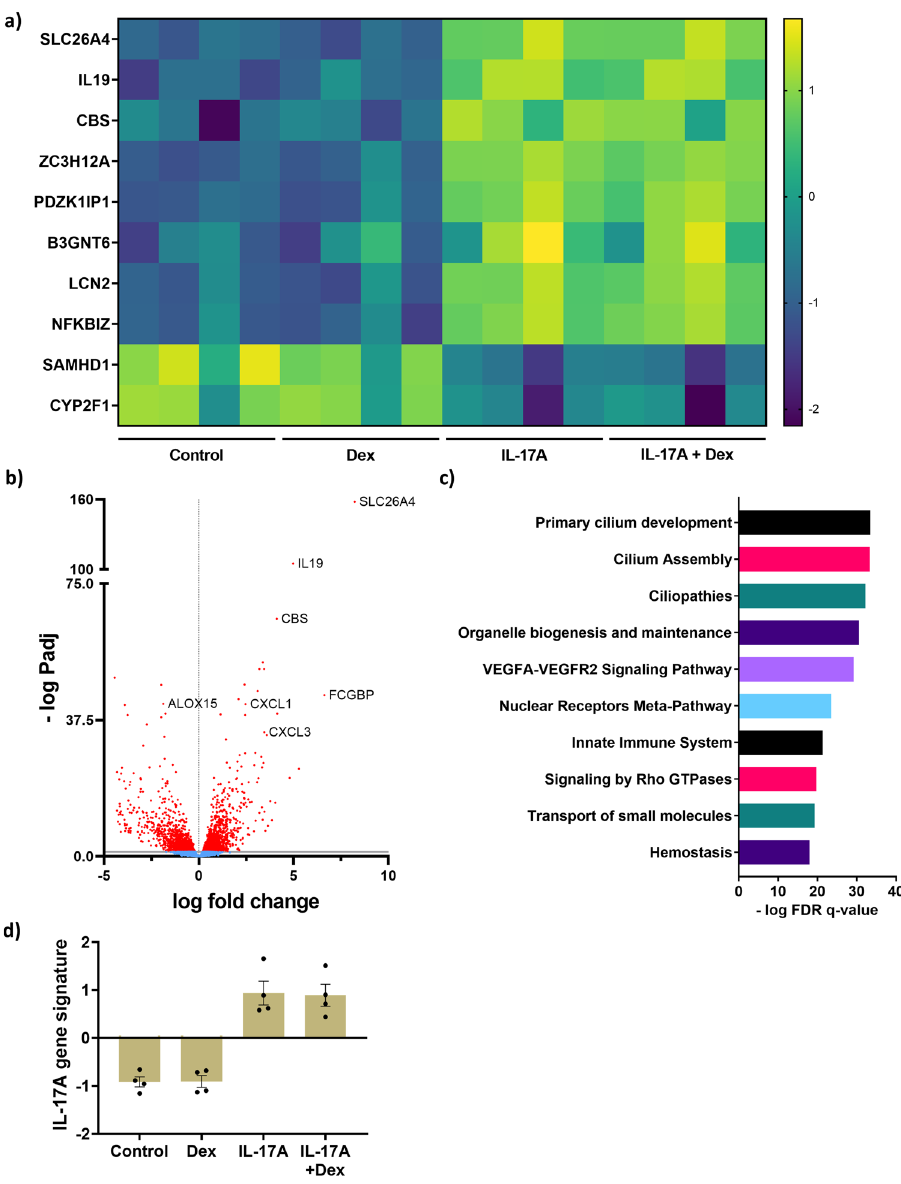
Figure 2. IL-17A induces gene expression that is insensitive to dexamethasone (Dex) in human airway epithelial cells (hAECs). hAECs were cultured and differentiated at an air liquid interface (ALI) and exposed to IL-17A (10 ng/ml) with or without dexamethasone (10 nM) for 14 days. Gene expression was determined by bulk RNA sequencing and differentially expressed genes were analyzed and presented as heatmap of the top 10 most regulated genes, with each column in the groups representing an individual donor ( a ) and by a volcano plot ( b ). Pathway analysis (GSEA) of the statistically significant genes was done and presented as the top 10 most regulated pathways ( c ). The IL-17A gene signature of the top 10 differentially expressed genes was calculated as Z-score ratio ( d ). Data represent means ± SEM. N = 4